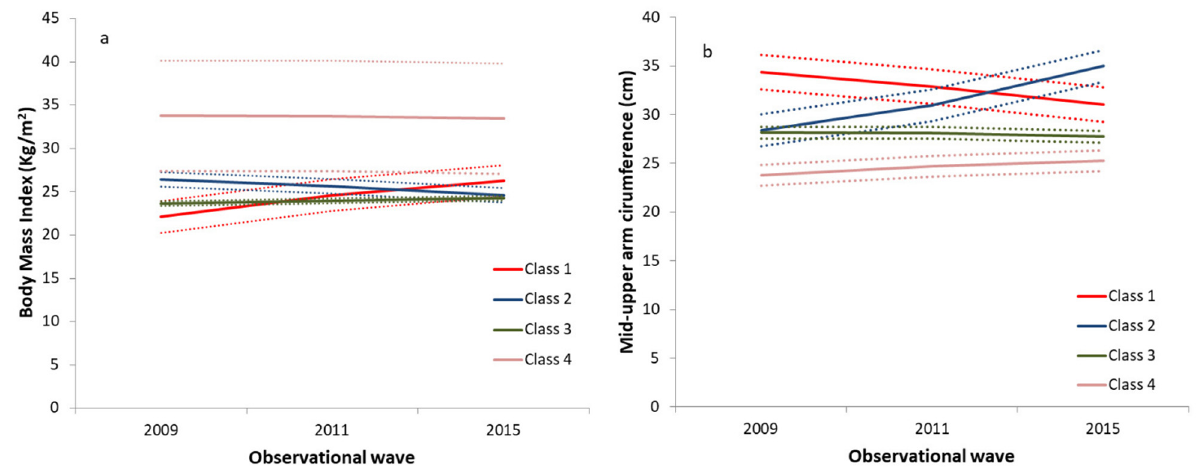
Figure 1. The BMI and MUAC trajectories modeled by GMM. ( a ) The plots for classifications of BMI trajectories by GMM. ( b ) The plots for classifications of MUAC trajectories by GMM. Abbreviations: BMI, body mass index; MUAC, mid-upper arm circumference; GMM, growth mixture model.